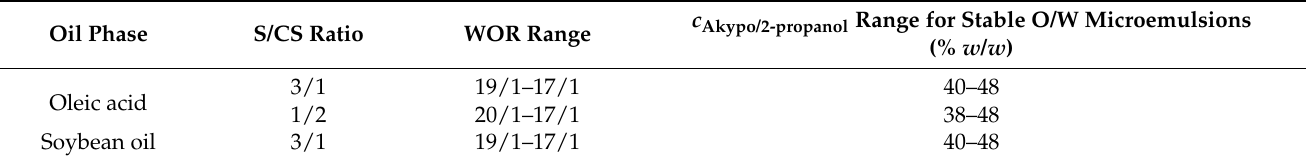
Table 1. Summary of the compositional range for obtaining stable O/W microemulsions which may be tested for encapsula- tion